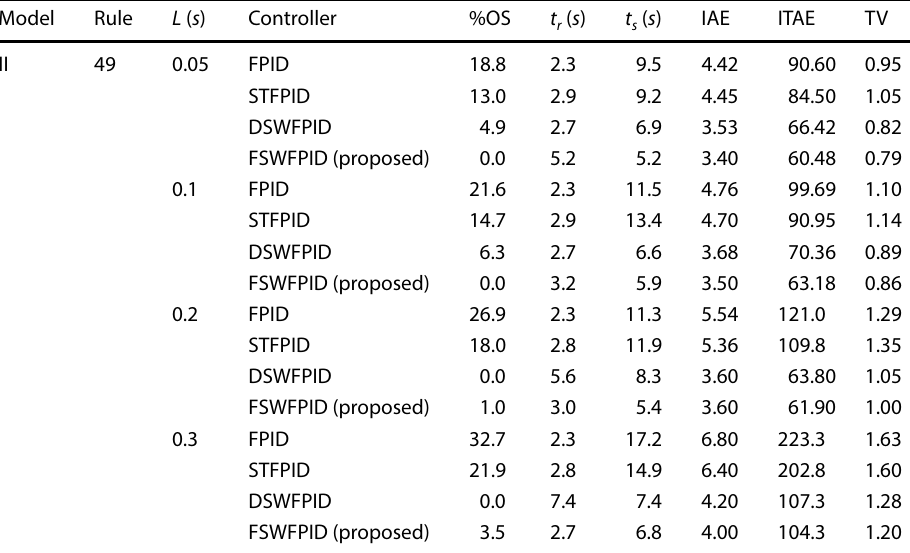
Table 7 Performance analysis for Model